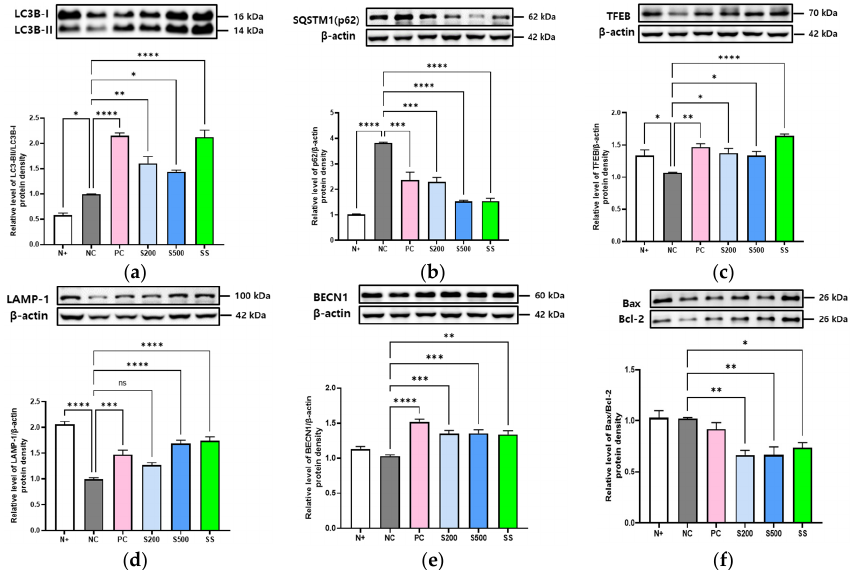
Figure 4. Stevia and stevioside induce autophagy in hepatocytes of db/db mice. Mice were orally administered saline (N+ and NC), saline with 200 mg/kg/day metformin (PC), saline with 200 or 500 mg/kg/day stevia (S200 and S500), and saline with 40 mM/kg/day stevioside (SS) for 3 weeks. ( a ) Microtubule-associated protein light chain 3B (LC3B)-II/LC3B-I. ( b ) Sequestosome1 (SQSTM1). ( c ) Transcription factor EB (TFEB). ( d ) Lysosomal associated membrane protein 1 (LAMP-1). ( e ) Beclin 1 (BECN1). ( f ) Bax/Bcl-2. All data are presented as the mean ± SE, n = 3 and represent results from three independent experiments. * p < 0.05, ** p < 0.01, *** p < 0.001, and **** p < 0.0001.